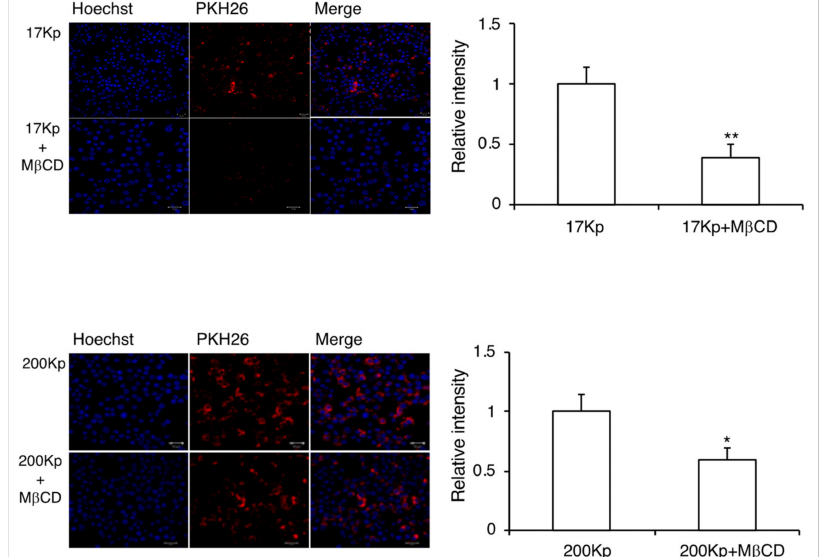
Figure 4. Effect of the clathrin-dependent endocytosis inhibitor on the intracellular incorporation of 17 Kp and 200 Kp into RAW264 cells. The 17 Kp or 200 Kp were stained with PKH26. Cells were treated with 10 mM of M β CD for 1 h, then 400 µ g protein/mL 17 Kp or 200 Kp for 2 h. Nuclei were stained with Hoechst33342. Cells were observed by confocal laser microscope. Asterisk indicates significant difference from the 17Kp or 200Kp group at * p < 0.05, ** p <